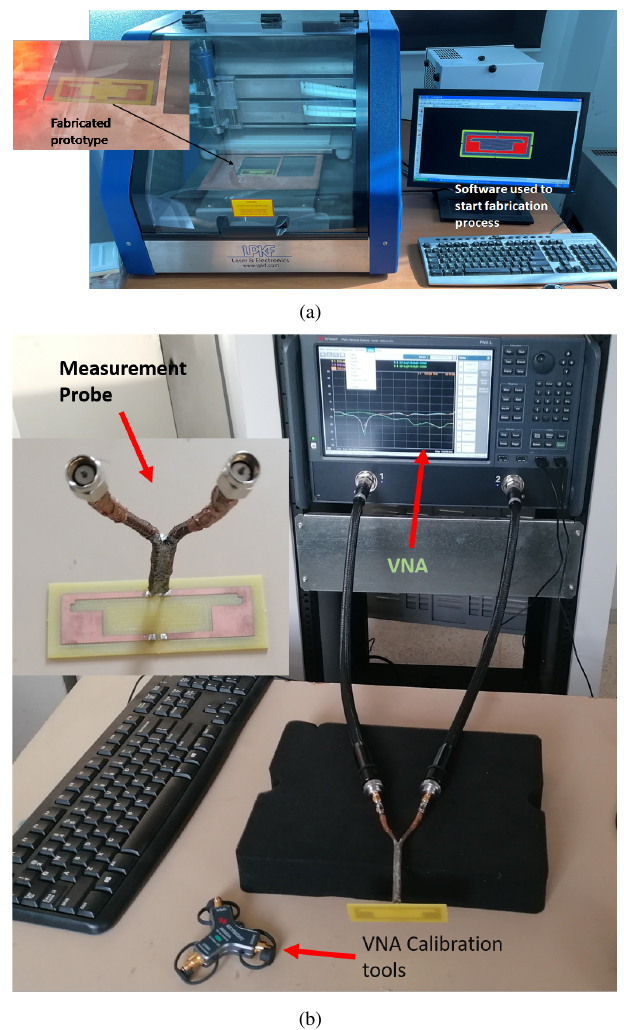
FIGURE 7: (a) Fabricated prototype, (b) experimental set-up form measuring the impedance of the fabricated